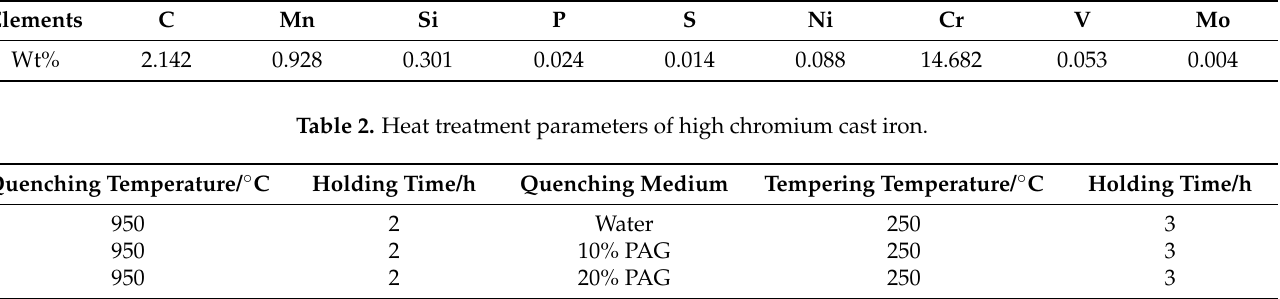
Table 1. The chemical composition of high chromium cast iron.